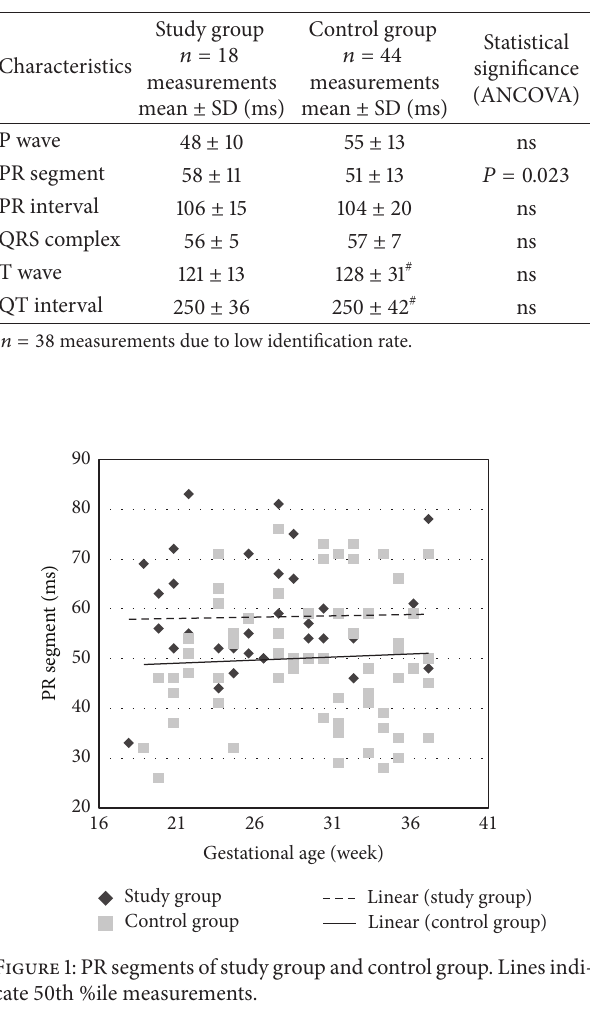
Table 3: Cardiac time intervals of the study group compared to those of the control group at 27–38 weeks of gestation ( 𝑃 value is adjusted for gestational age, gender, and weight).